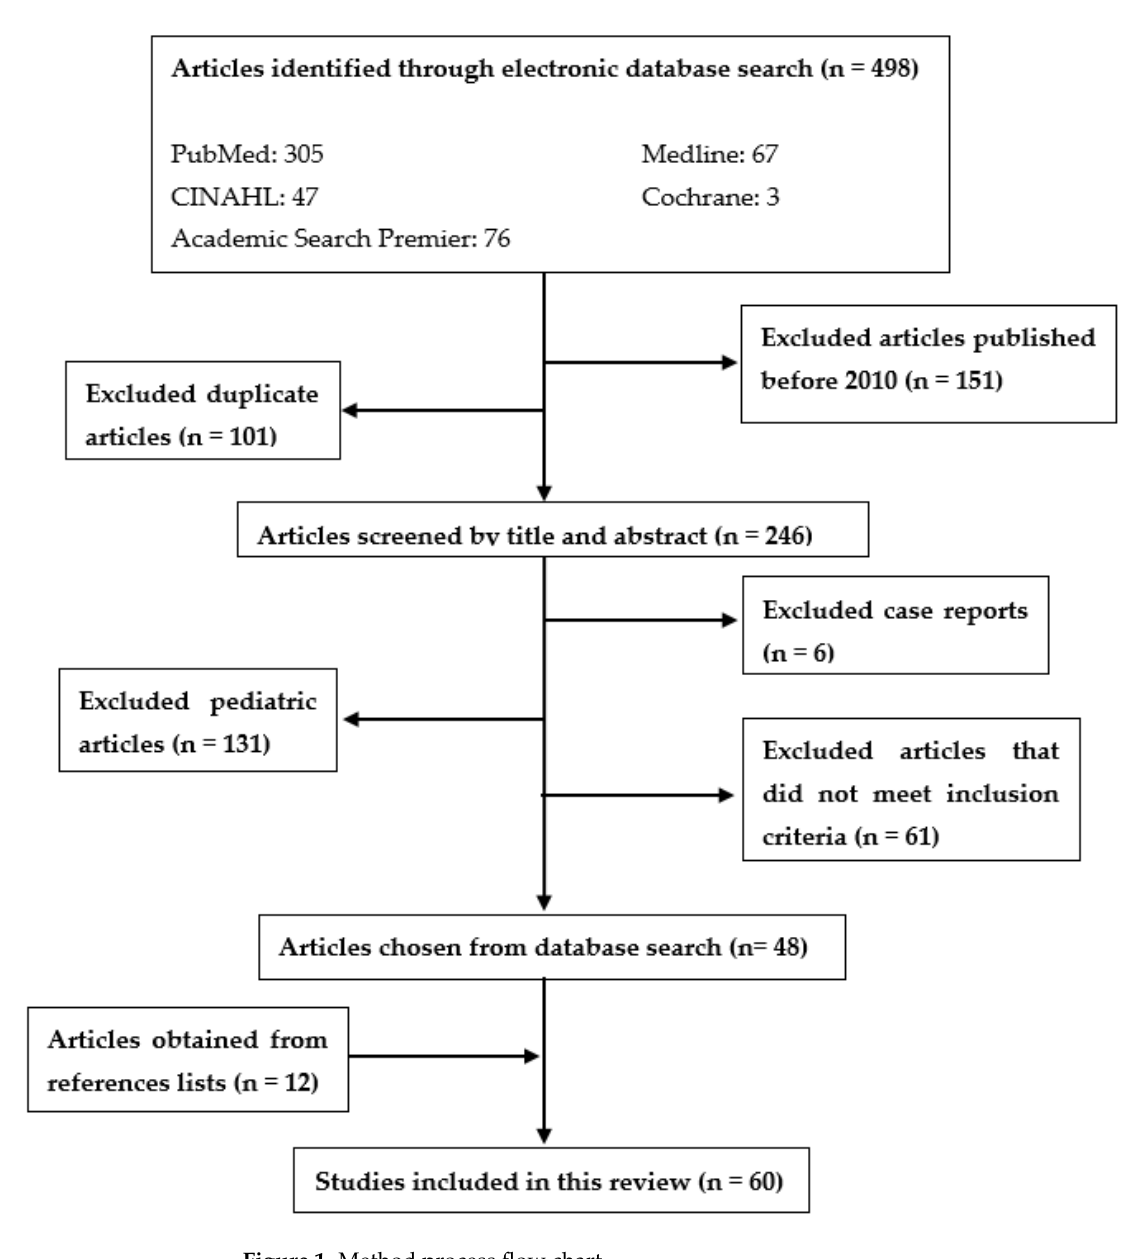
Figure 1. Method process flow chart.